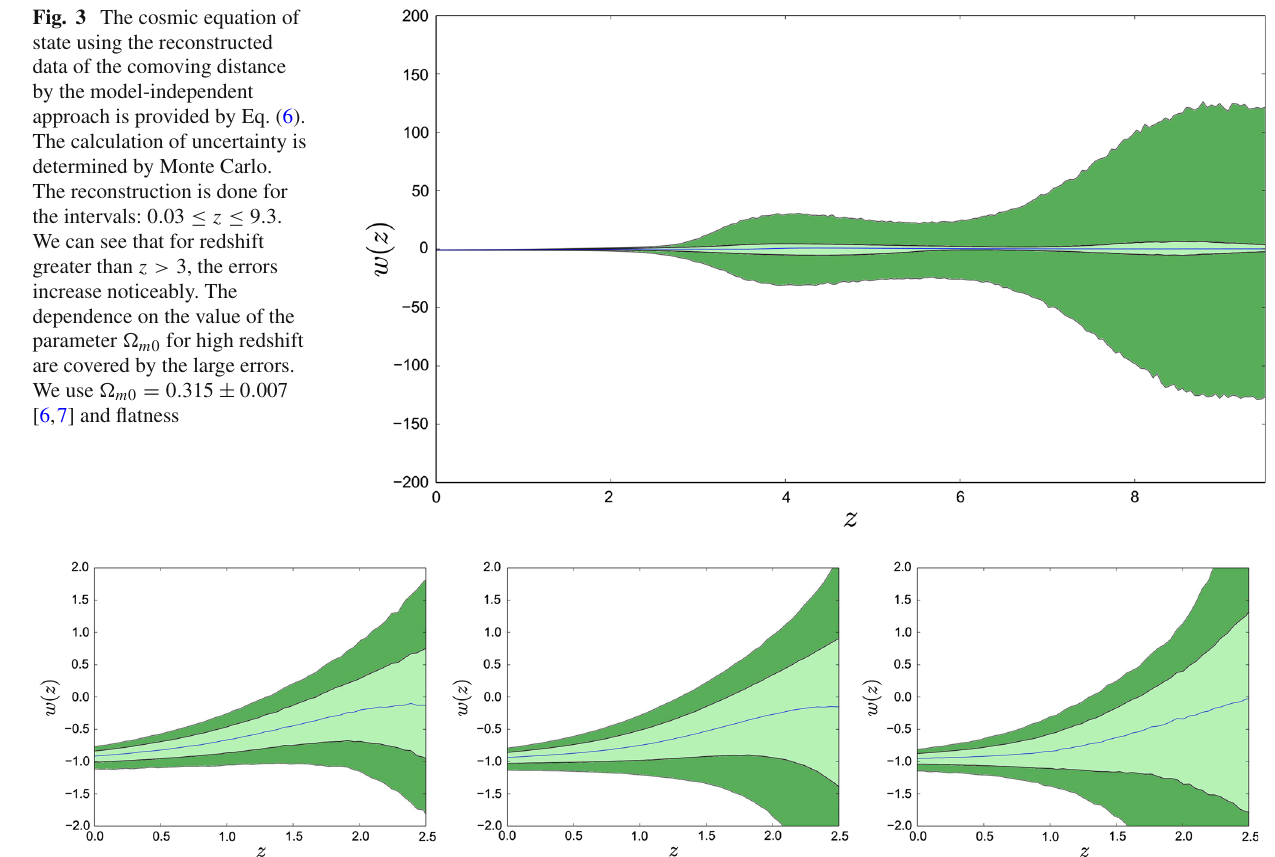
Fig. 4 We show the dependency of the reconstruction of the state equation with the value of (cid:3) m 0 . This dependence is evident for minor redshifts that are depicted in the 3 figures. In the left, (cid:3) m 0 = 0 . 200; in the centre, (cid:3) m 0 = 0 . 275 and; to the right, (cid:3) m 0 = 0 . 400